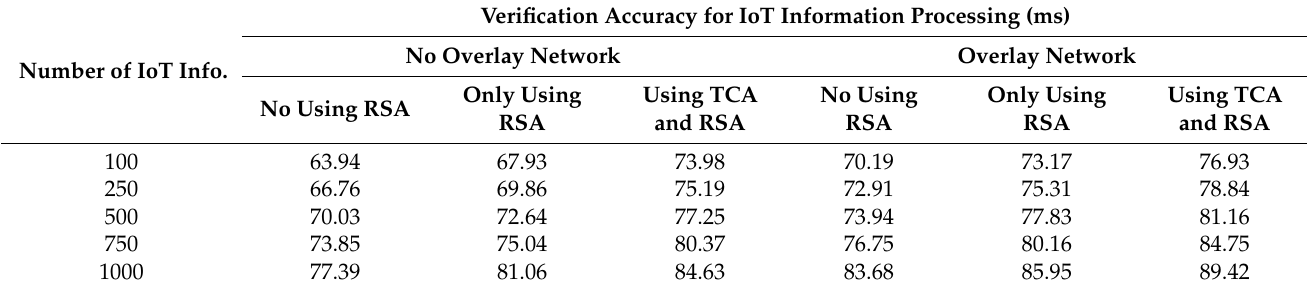
Table 8. Comparison of blockchain-based integrity verification accuracy.